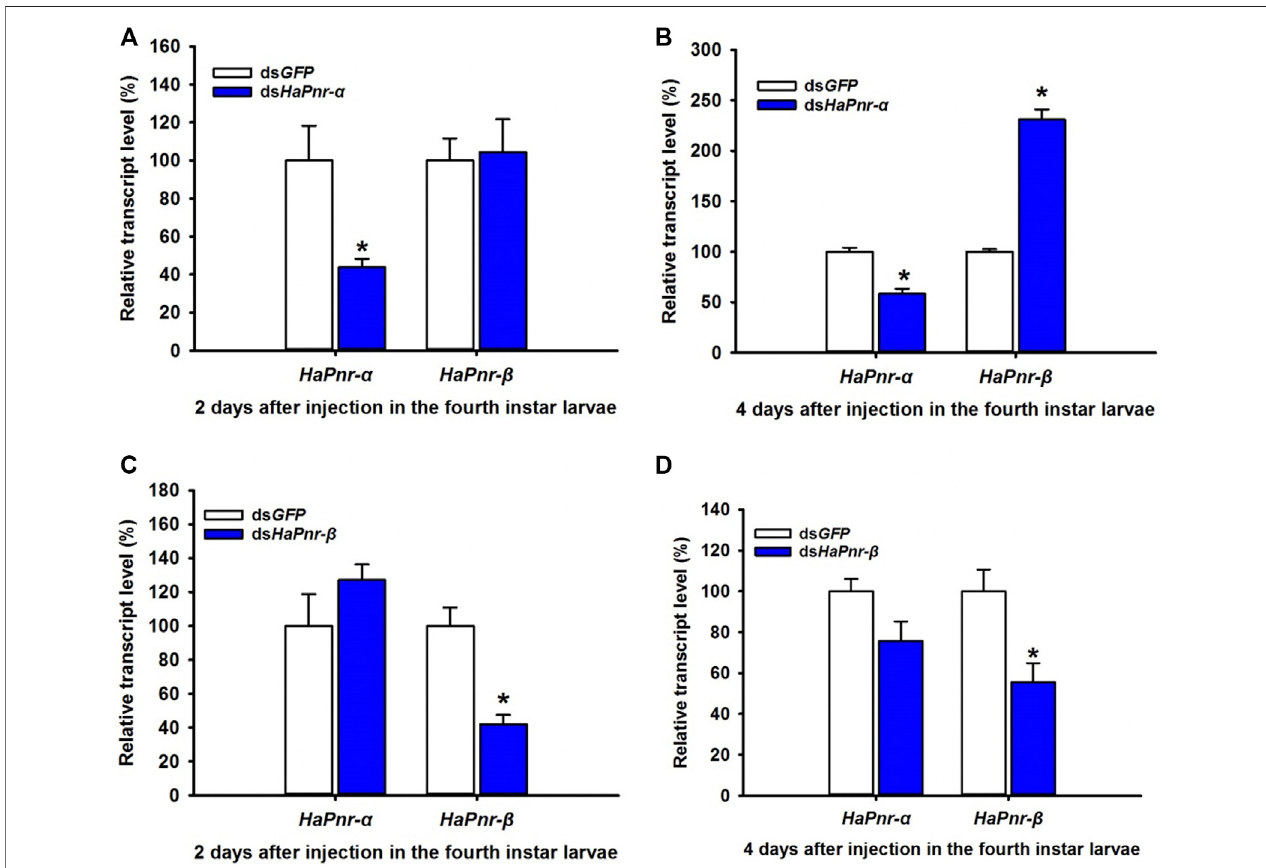
FIGURE6| Suppressionof HaPnr- α (A,B) and HaPnr- β (C,D) transcriptinthefourth instarlarvaeof H.axyridis injected withdsHaPnr- α ,dsHaPnr- β ,anddsGFPat 300 ng/larva as determined by RT-qPCR.